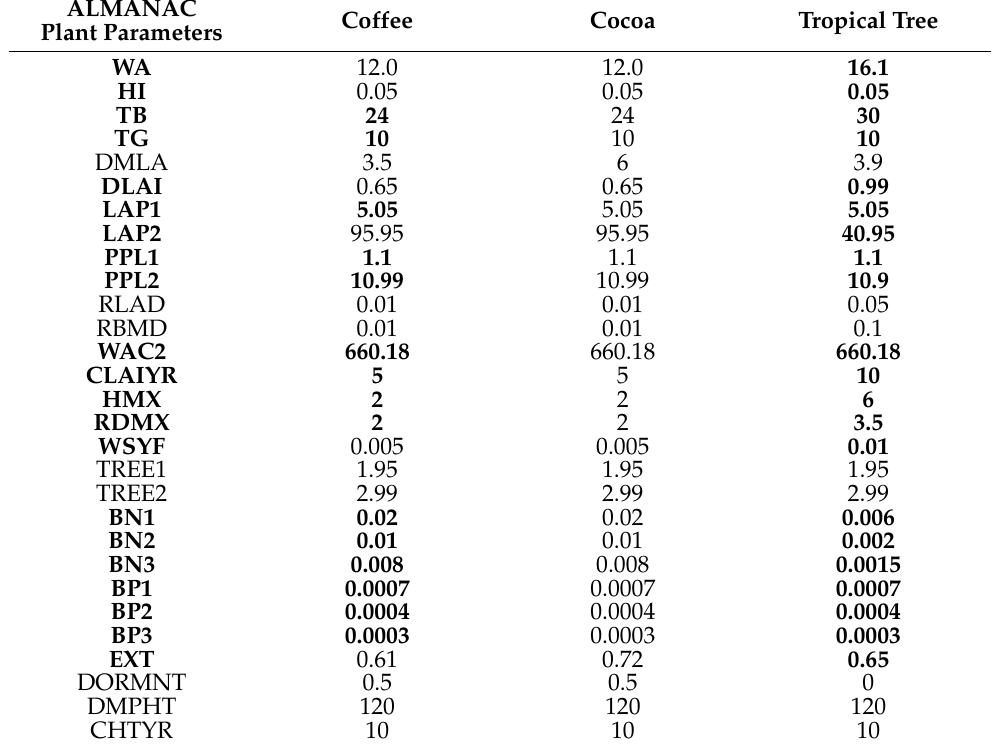
Table 3. Plant parameters used in this study. Parameters in bold font were adjusted from measured data by Josimar Gurgel Fernandes (personal communication) to simulate these three tree species. ALMANAC Coffee Cocoa Tropical Plant Parameters